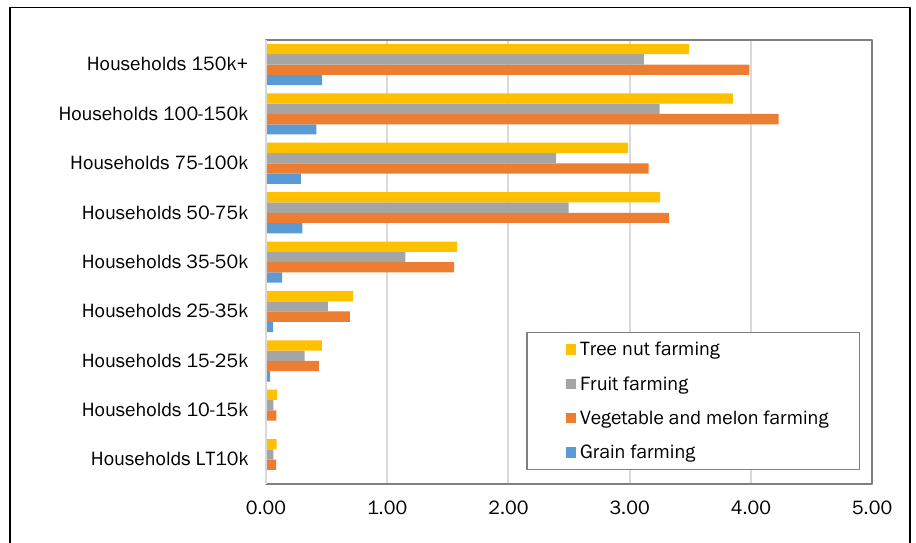
Figure 1. Percent Change in Aggregate Multipliers from 20% Change in Household Purchases in Local Food